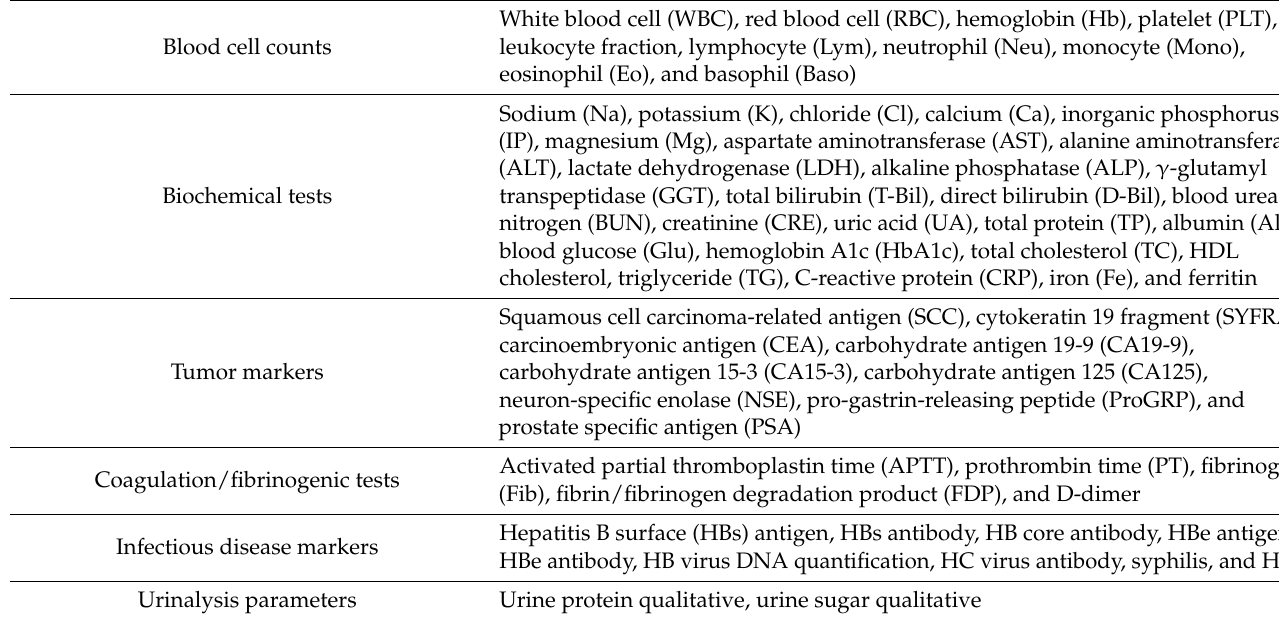
Table 2. Laboratory test